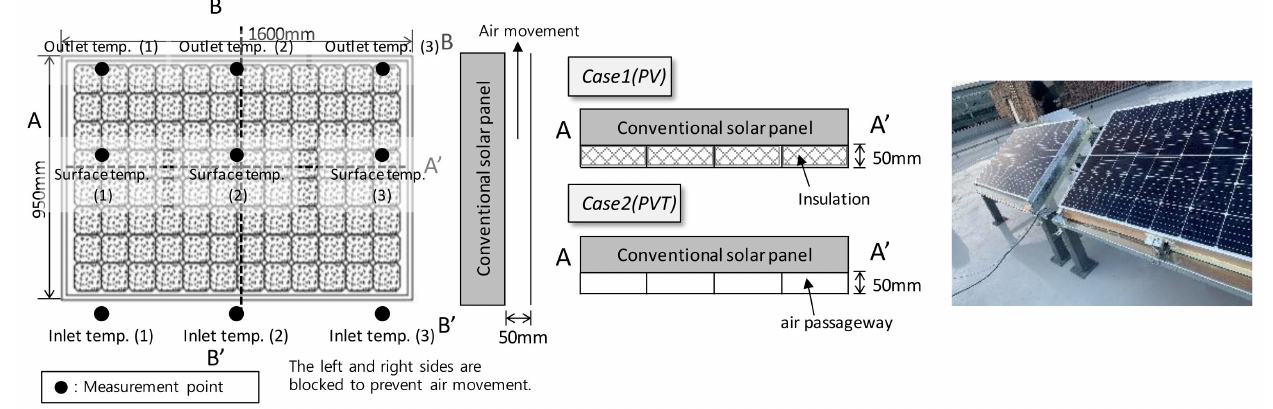
Figure 1. Schematic of experimental